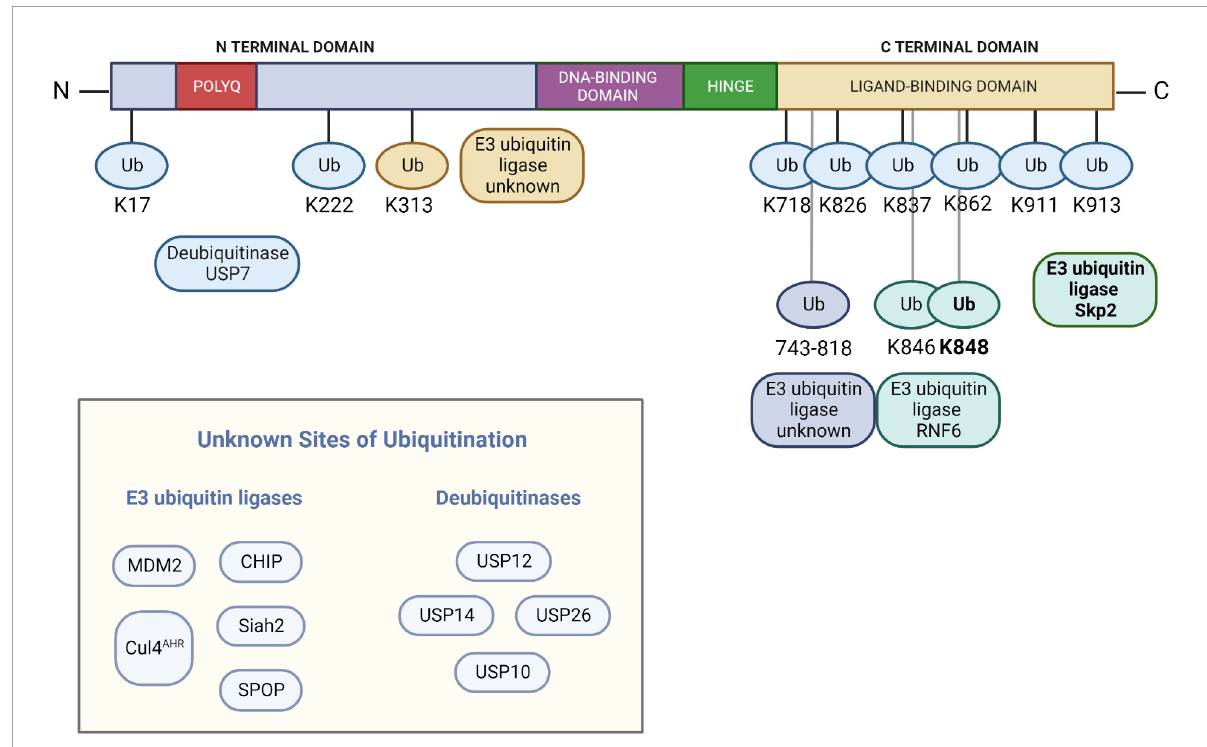
FIGURE1 The known E3 ubiquitin ligases and deubiquitinases that impact the ubiquitination status of the androgen receptor, along with sites of ubiquitin modification (if known). Note that Skp2 modifies K848 with K48 polyubiquitin chains while RNF2 modifies both K846 and K848 with K6, K27, and K63 polyubiquitin chains. AR numbering is based on NCBI reference sequence NM_000044.6 and UniProtKB/Swiss-Prot: P10275.3. Figure created with